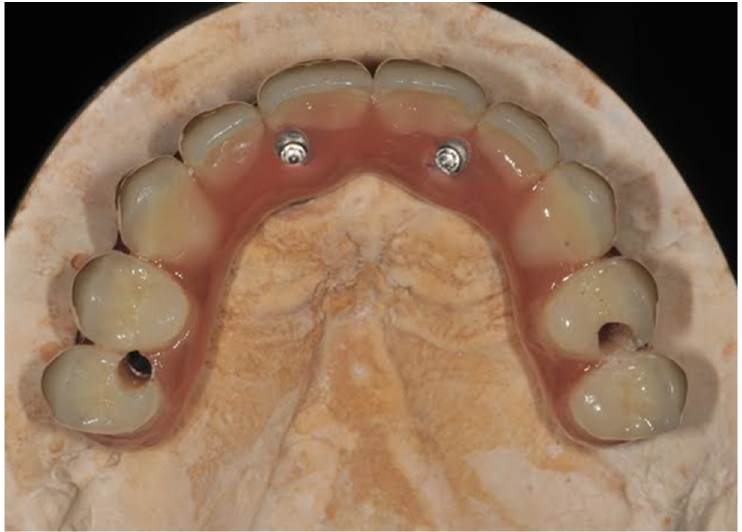
Figure 2. Provisional prosthesis. Notice that during provisional rehabilitation, posterior load is characterized by the absence of distal cantilever. Teeth n. 25 was thus shortened to eliminate any load.